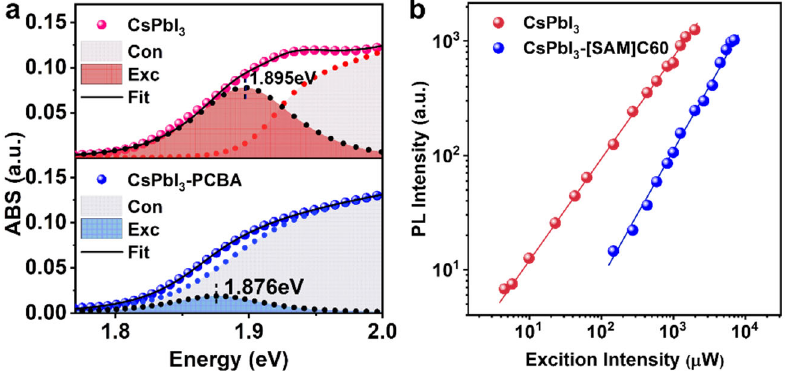
Figure 3. ( a ) The band ‐ edge absorption of CsPbI 3 QDs and CsPbI 3 ‐ [SAM]C60 QDs fitted with Elliott formula (Con and Exc represent continuous band and exciton absorption, respectively). ( b ) Excita ‐ tion power ‐ dependent PL spectra. Table 1. Parameters fitted from absorption spectrums with Elliott formula.